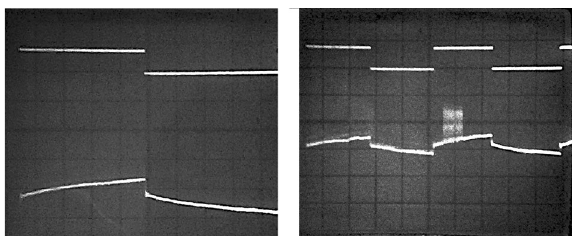
Figure 6. A system response on the Heaviside function signal (upper beam) is shown on the left. Recording duration is 2.5 s. The equipment bandwidth starts at zero frequency. It is easy to observe that after a rapid, momentary θ deviation because of the acoustic wave propagation, the further post-impulse rotation continues in the same direction. There is a 5 s fragment of the record on the right, which shows an unsuccessful attempt to interfere to the post-impulse rotation process by turning on (briefly) an additional more powerful transmitter. The interference is visible on the lower beam of the